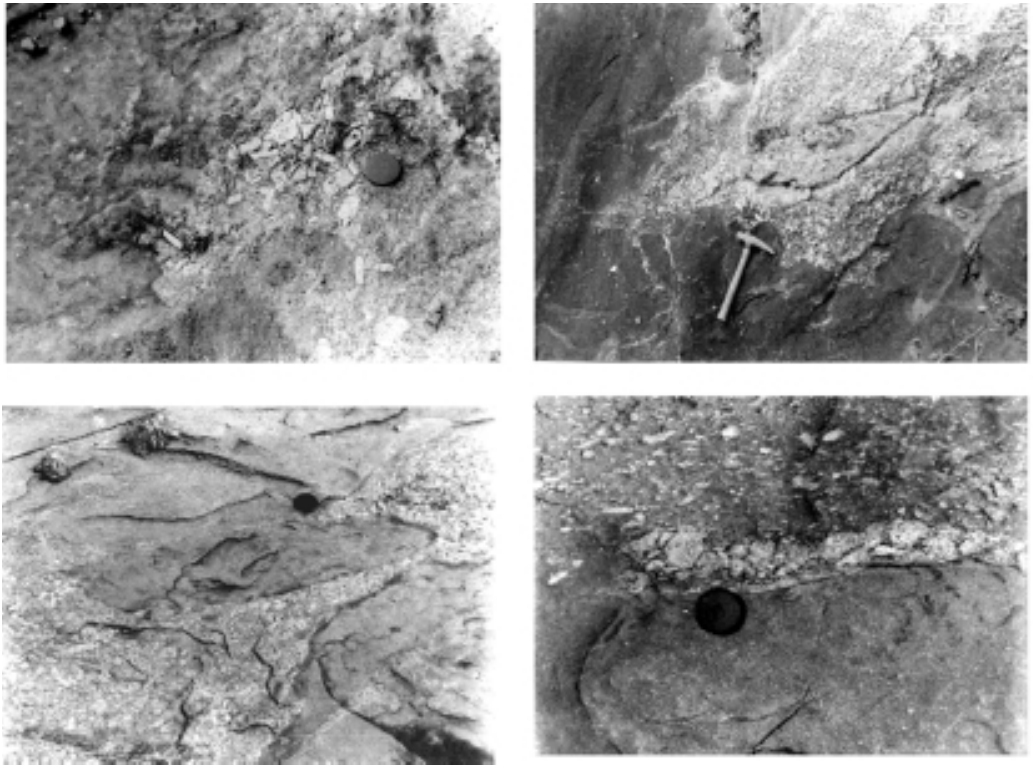
dioritic lobate